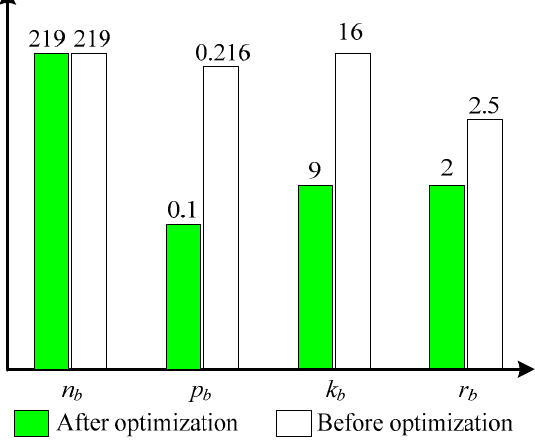
Figure 11. Part networking parameters -before and after optimization.